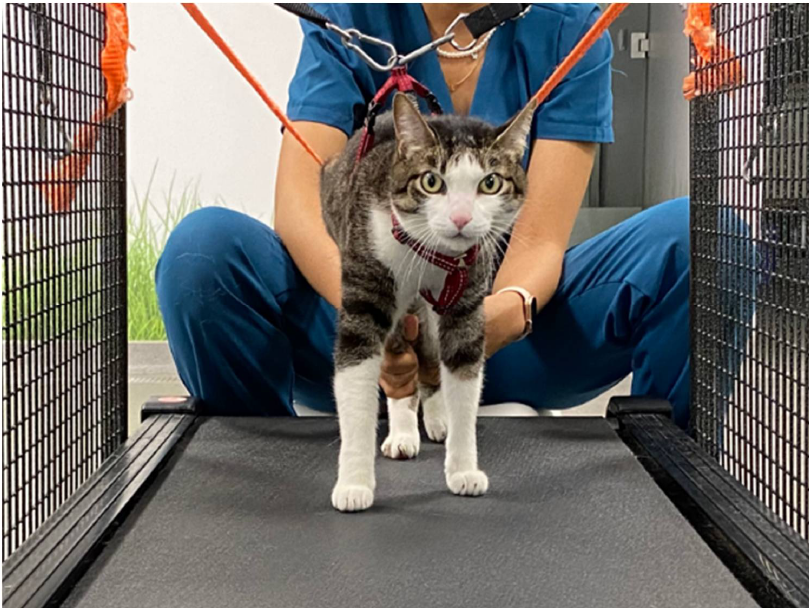
Animals 2021 , 11 , x Figure 1. Quadrupedal locomotor training (QLT) performed on a land treadmill. Figure 1. Quadrupedal locomotor training (QLT) performed on a land treadmill.